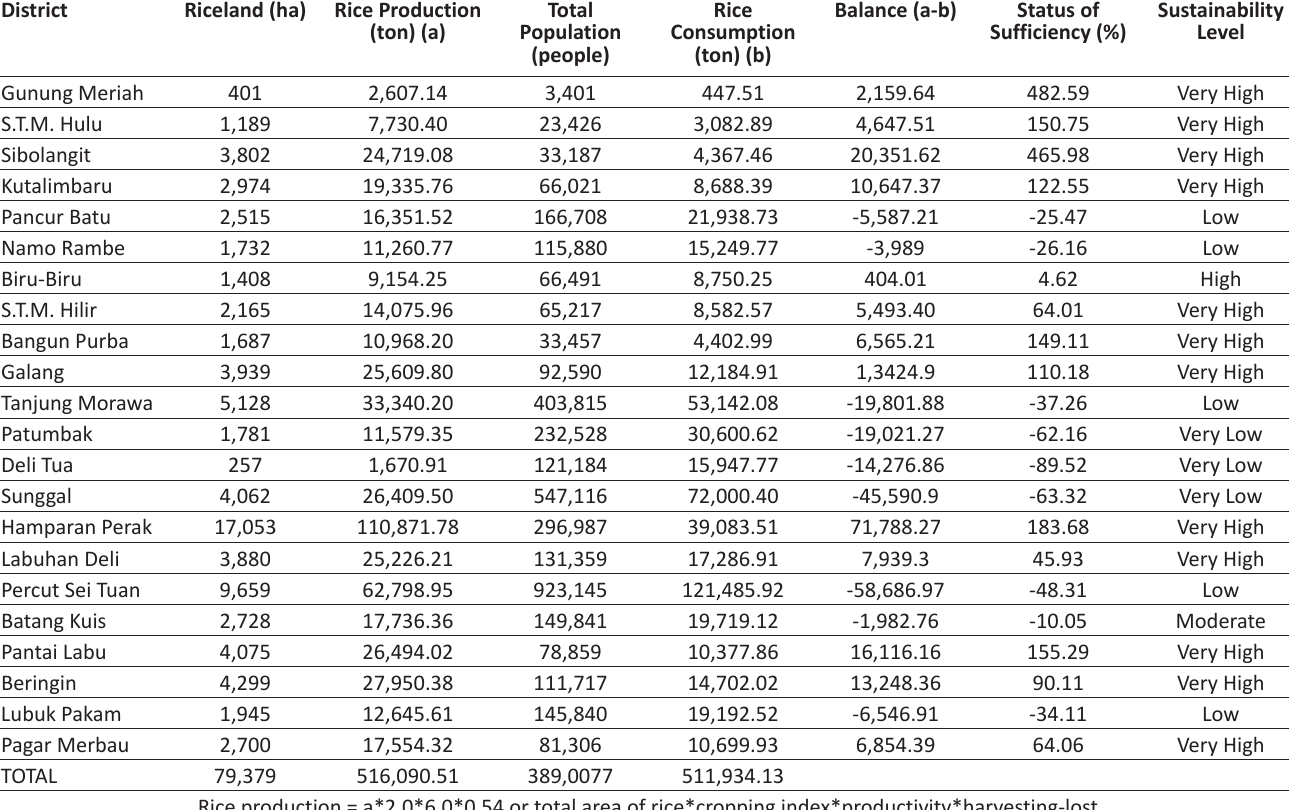
Table 6 . Rice production sustainability of Deli Serdang Regency by 2040 based on PRP scenario.